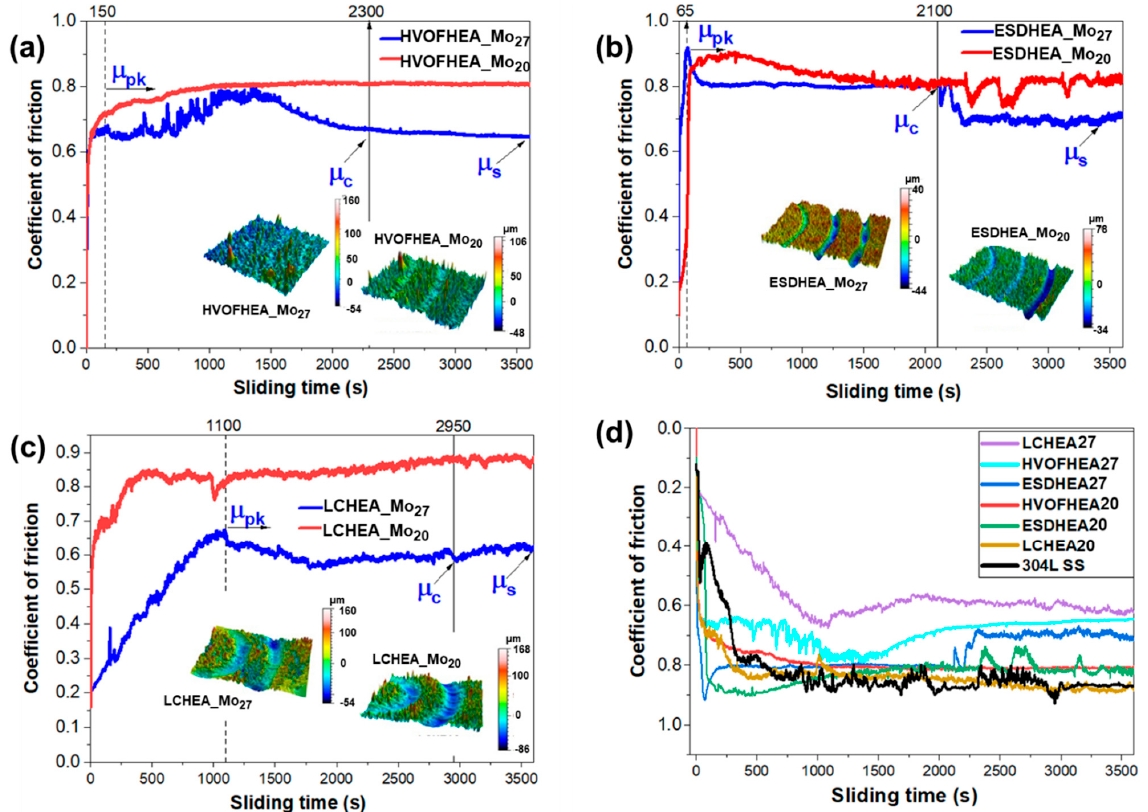
Figure 9. Evolution of coefficient of friction (CoF) versus sliding time after 12,000 wear cycles under dry test condition for the as-sprayed ( a ) HVOF, ( b ) ESD, ( c ) LC -HEA coatings and ( d ) 304L SS and HEACs with the different deposition techniques. Table 5. Averaged transition stages in the friction traces of HEA_Mo 27 coatings from the different deposition techniques assigned as: Break-in peak value— µ pk ; coating run-through— µ c ; sub-stresses from substrate— µ s .